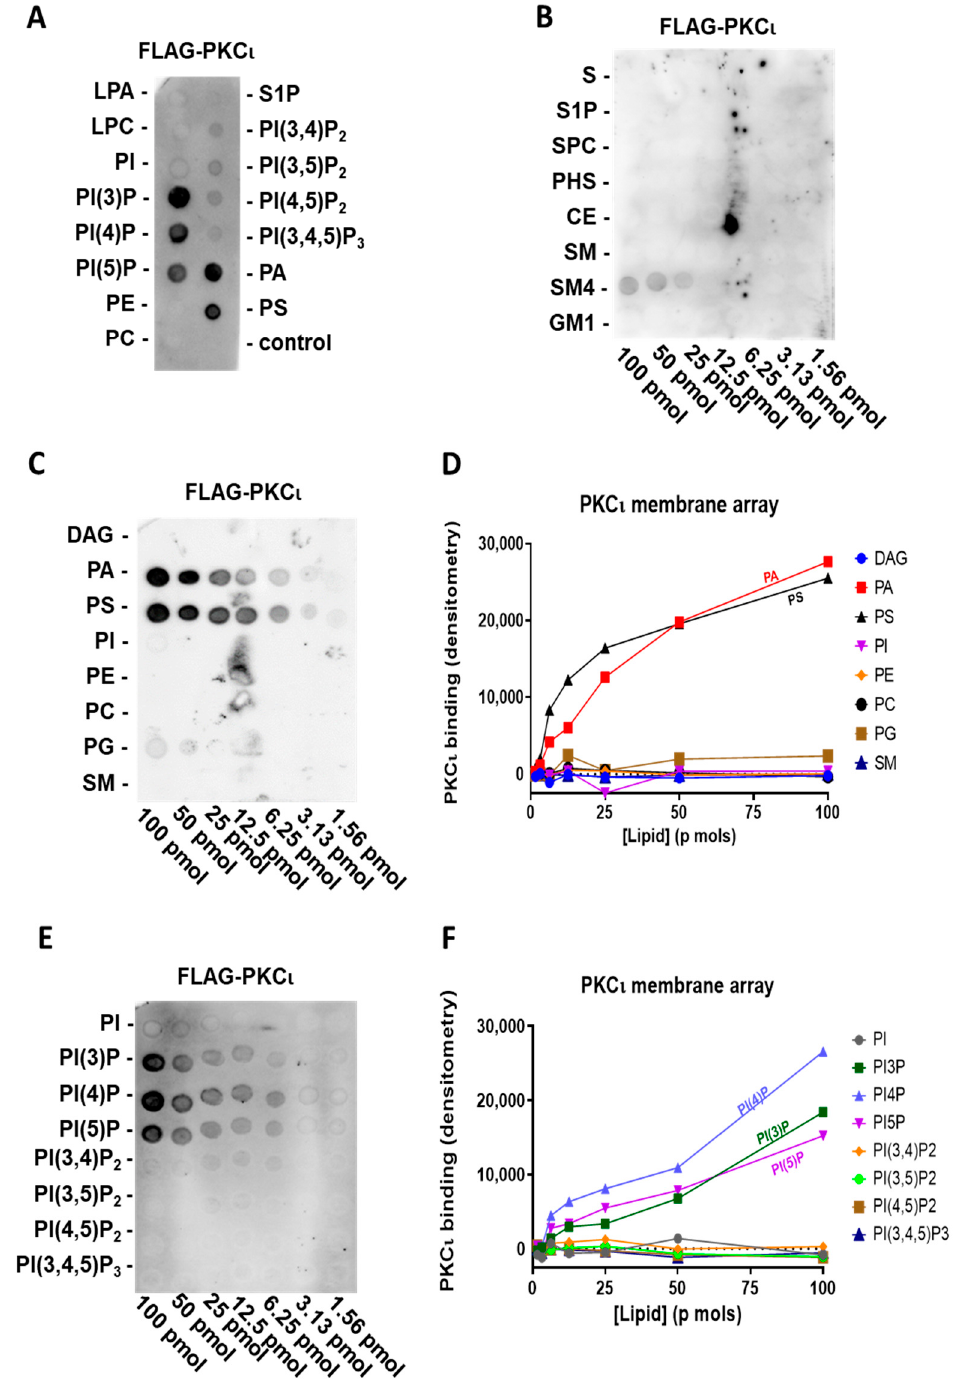
Figure 2. PKC ι binds PIPs, PA, and PS ( A ) Highly purified FLAG-PKC ι was incubated with a PIP strip overnight and, after washing, detected with anti-FLAG antibody. ( B ) Highly purified FLAG- PKC ι was incubated with sphingolipid array overnight and, after washing, detected with anti-FLAG antibody. ( C ) Highly purified FLAG-PKC ι was incubated with a membrane lipid array overnight and, after washing, detected with anti-FLAG antibody (left). ( D ) Quantification by densitometry of ( C ). ( E ) Highly purified FLAG-PKC ι was incubated with a PIP array overnight and after, washing detected, with anti-FLAG antibody (left). ( F ) Quantification by densitometry of ( E ). Using the membrane lipid array P-6003 that has been spotted with DAG, PA, PS, PI, PE, PC, PG, and SM in a concentration gradient, we can confirm that also PKC ι binds to